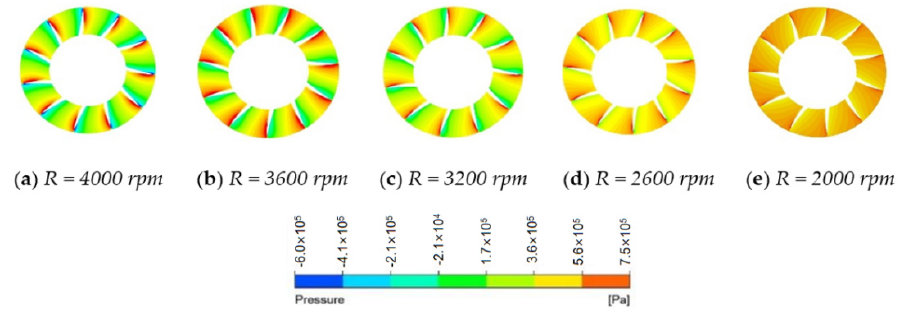
Figure 14. Pressure cloud of the rotor domain at different rotating speeds when β = 20 ◦